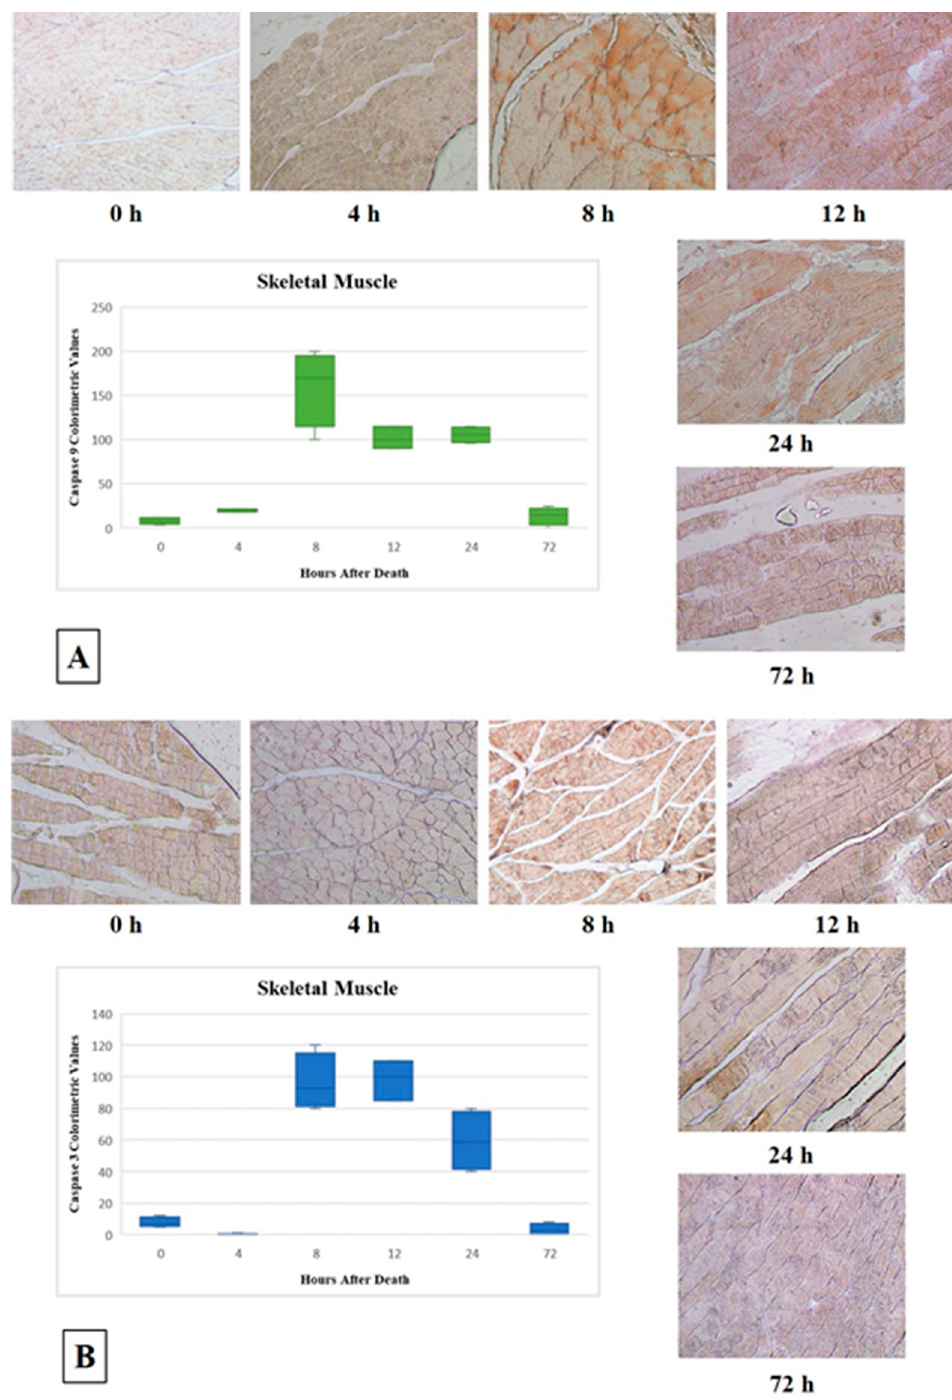
Figure 1. Graphs (boxplot) showing the median, minimum, and maximum of Caspase 9 and Caspase 3 expression (respectively ( A , B )) in skeletal muscle at each PMI group and related representative images on immunopositivity observed at the designated time of PMI (Caspase 9—0 h: 10 × ; 4 h: 20 × ; 8 h: 10 × ; 12 h: 20 × ; 24 h: 20 × ; 72 h: 20 × . Caspase 3—0 h: 10 × ; 4 h: 10 × ; 8 h: 10 × ; 12 h: 10 × ; 24 h: 20 × ; 72 h: 20 × ).